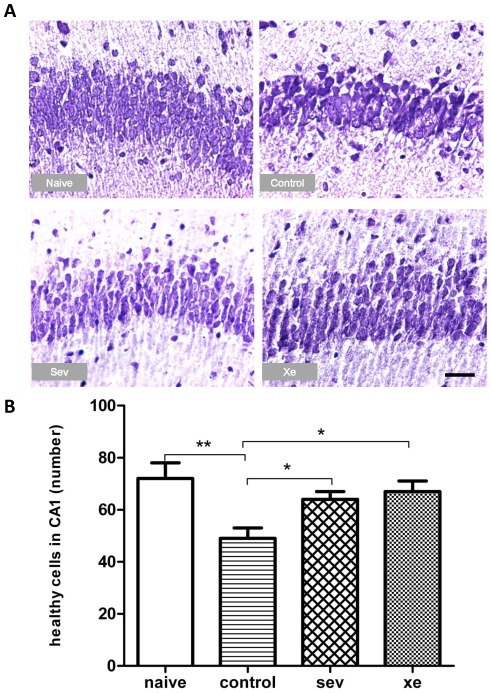
Morphological changes in the hippocampus.Photomicrographs show cresyl violet staining in CA1 region of hippocampus (A, 40×) on PND 7. Neuronal loss, cellular disorganization and shrinkage were attenuated in sevoflurane or xenon groups compared to control group. There is a significant difference in the number of healthy cells in control group, compared to all other groups (B). Results are mean ± SEM (n = 6). * p<0.05, **p<0.01.